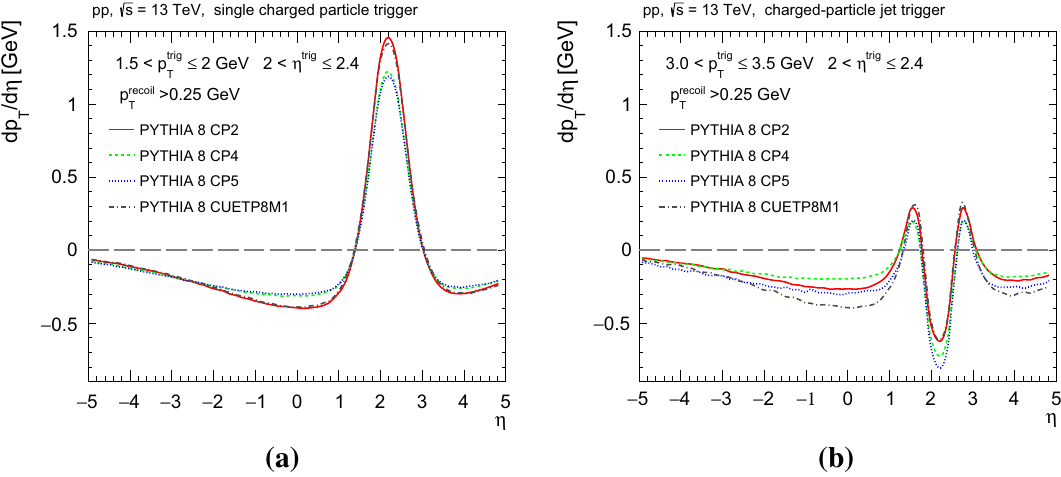
Fig. 10 Rapidity correlation of recoiled system with respect to single-charged particle with 1.5 ≤ p T < 2 GeV ( a ) and with respect to charged- √ s = 13 particle jet with 3 ≤ p T < 3.5 GeV ( b ) at